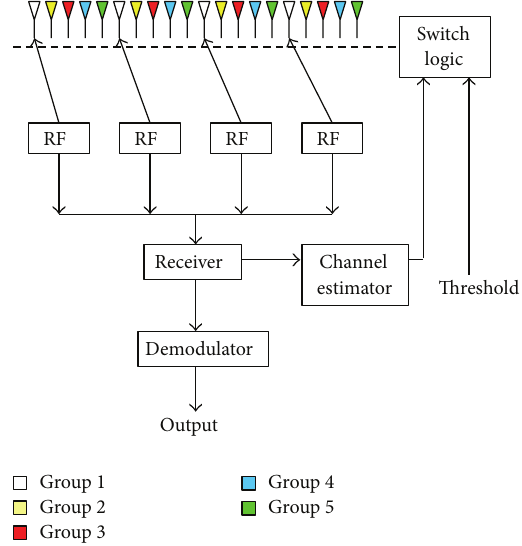
Figure 4: Operation model of GSEC ( 𝑁 𝑅 = 20 , 𝐿 𝑅 = 4